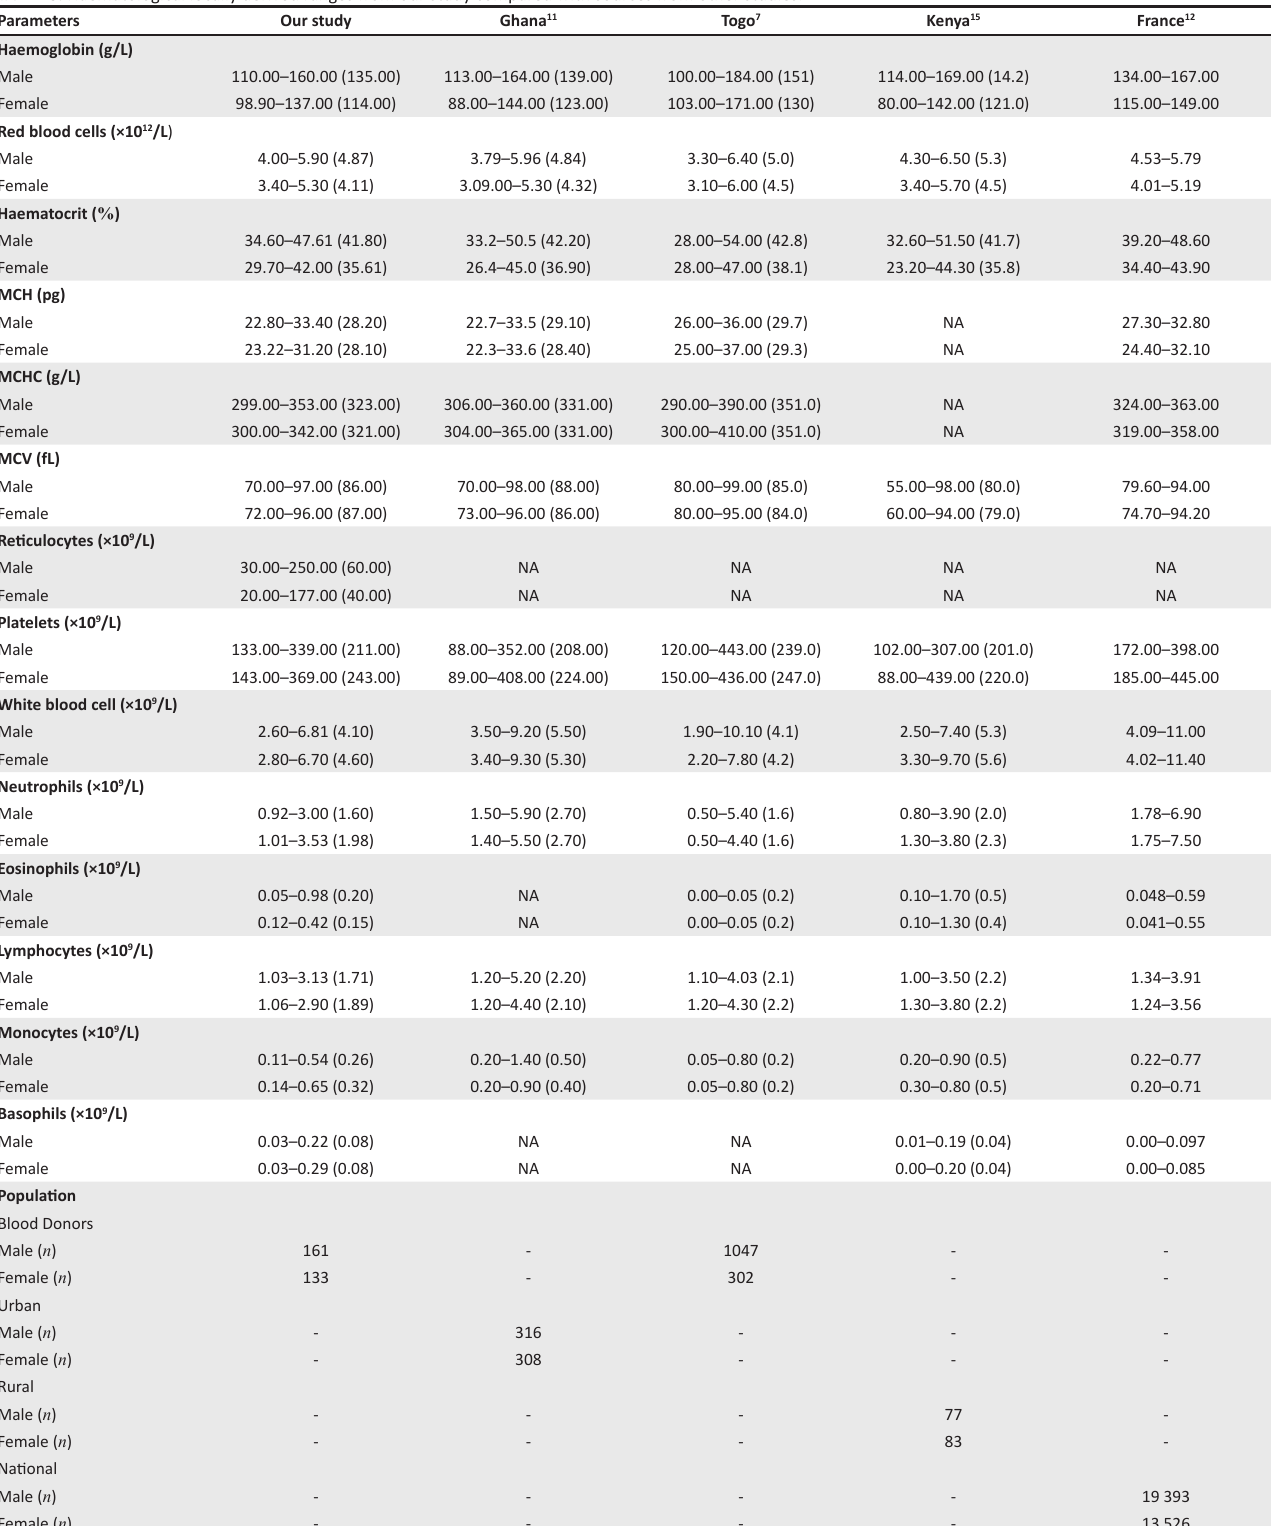
TABLE 6: Haematological locally derived ranges from our study compared with sources from other studies.